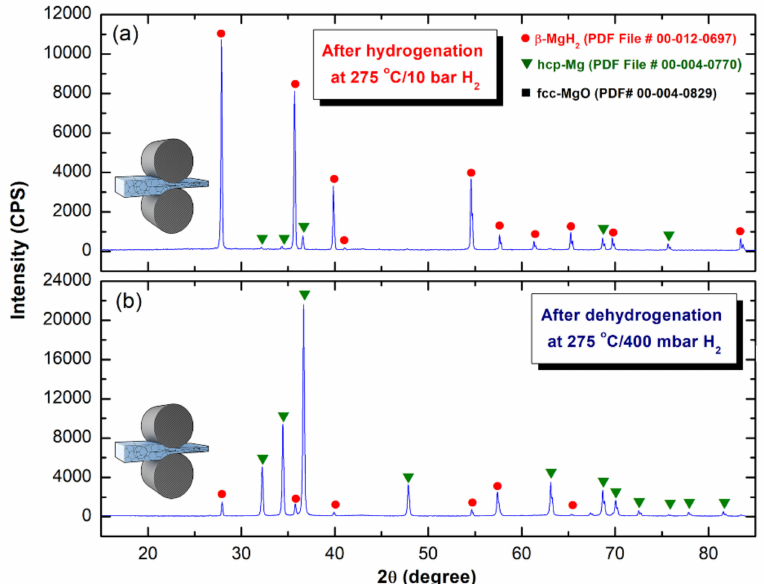
Figure 14. The XRD patterns of the 150 passes-sample obtained after ( a ) hydrogenation at 275 ◦ C / 10 bar H 2 , and ( b ) dehydrogenation at 275 ◦ C / 400 mbar H 2